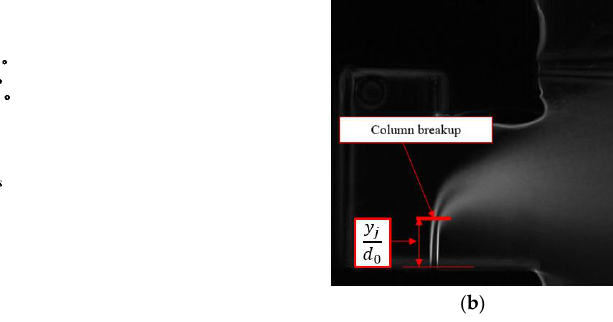
Figure 18. ( a ) Schematic of a typical JICF breakup process [15], and ( b ) definition of the column breakup point.